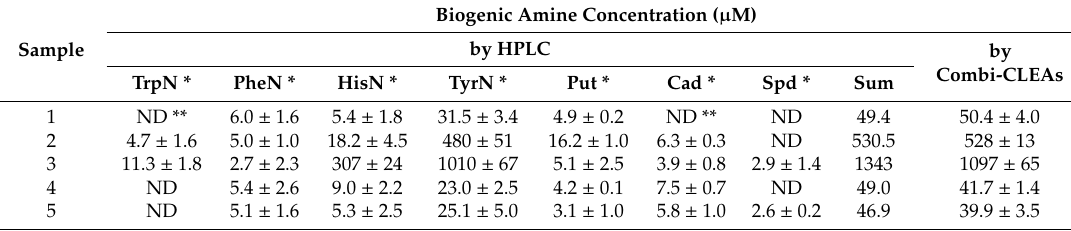
Table 3. Analysis of biogenic amines in Korean doenjang using HPLC and enzymatic method using